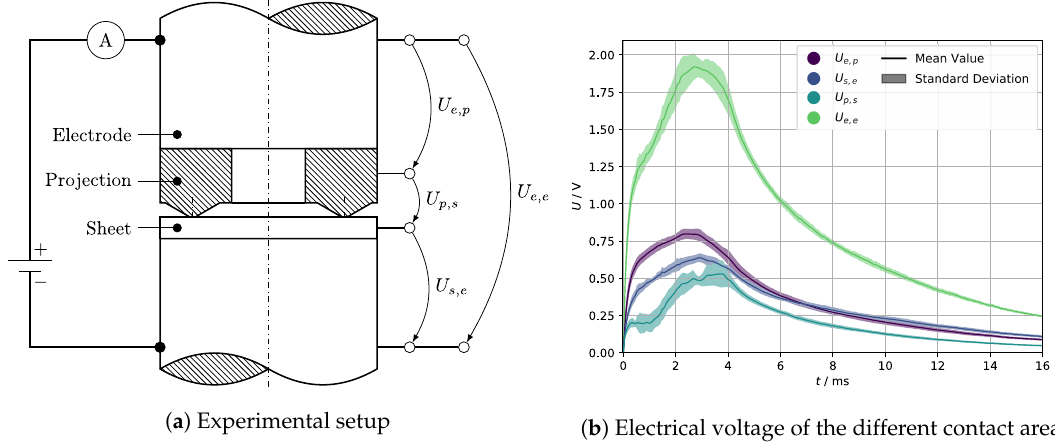
Figure 5. Schematic representation of the experimental setup ( a ) and the mean value with standard deviation of the measured voltage of all contact areas ( b